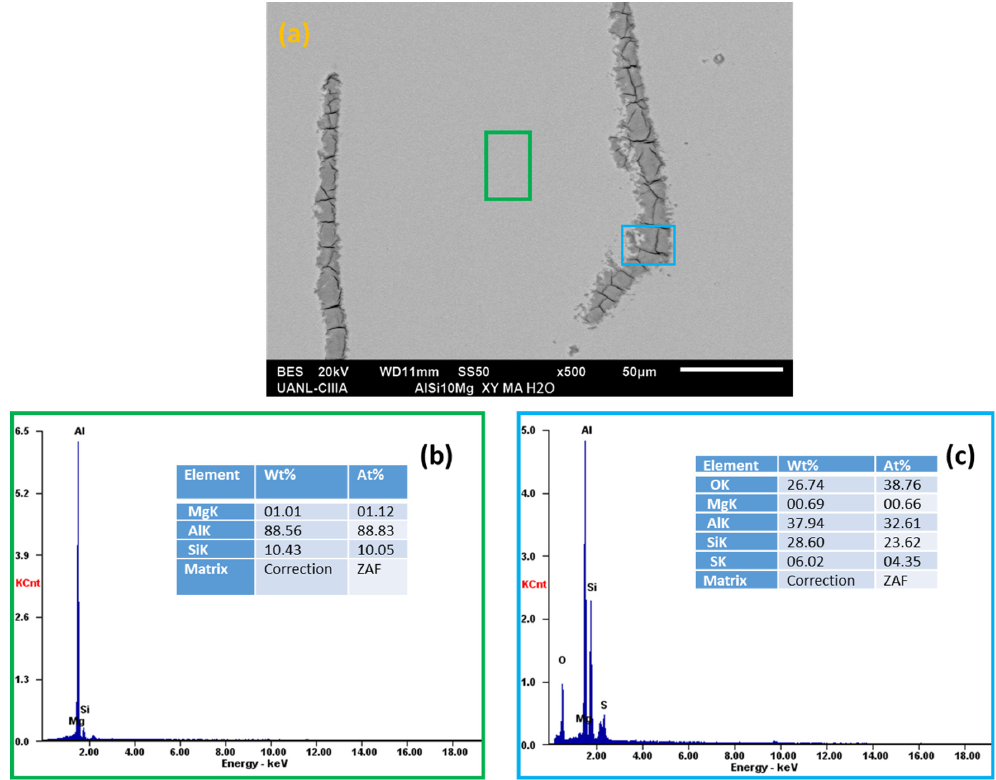
Figure 20. SEM-EDS surface morphology micrographs of Al-A.M. ( a ) alloys in H 2 O solution and EDS spectrum analysis: ( b ) green box and ( c ) blue box.